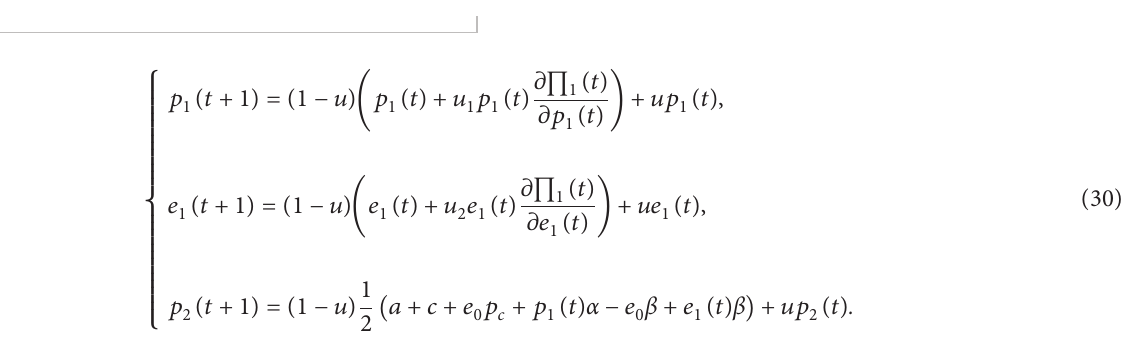
, p , and e when u 1 2 1